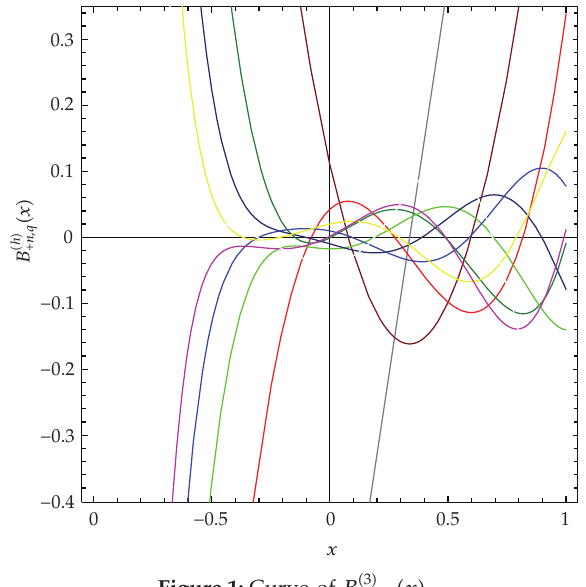
Figure 1: Curve of B